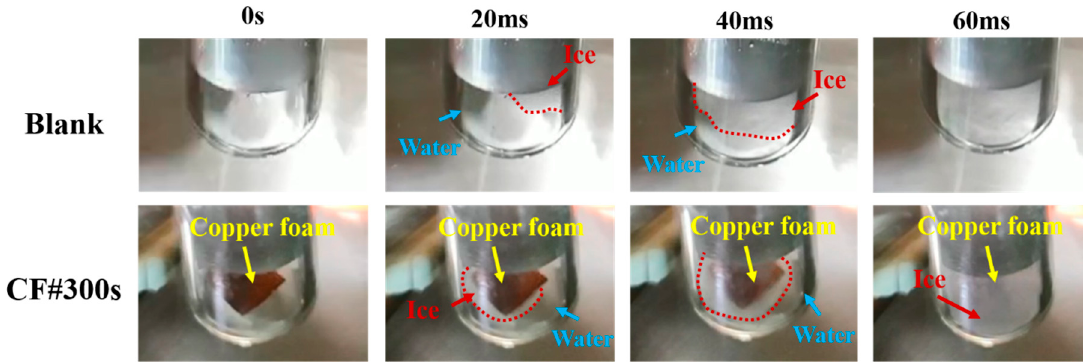
Figure 7. Picture of solidification progress of Blank and CF#300s.